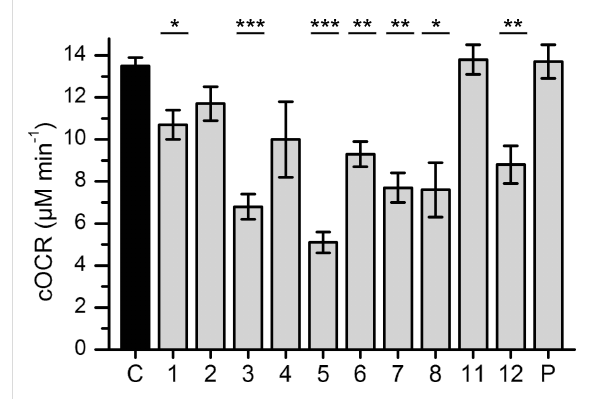
Figure 2: Inhibition of cellular O 2 consumption rate (cOCR) of S. aureus Newman. Cell suspensions (OD 600 nm of 0.5) were incubat- ed with 100 µM of the indicated AQs ( 1 – 12 ), PQS (P) or an equal amount of DMSO as the control (C). Black and grey bars show the mean cOCR of three biological replicates. Error bars represent the standard error. One-way ANOVA was used for statistical analysis, and significant differences compared to the control are indicated (* P < 0.05, ** P < 0.01, *** P <